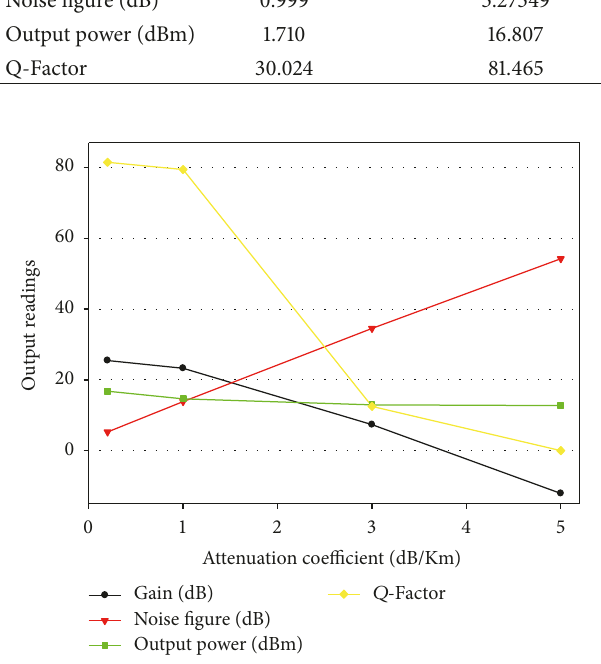
Figure 7: Output readings by varying the attenuation